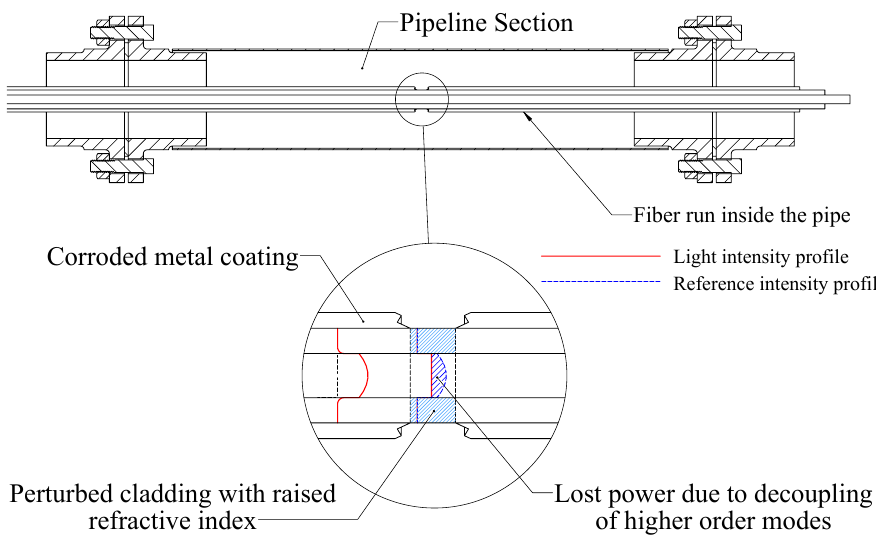
Figure 1. Operation principle of the distributed fiber optic corrosion sensor when exposed to hydrocarbons showing the resulting light intensity